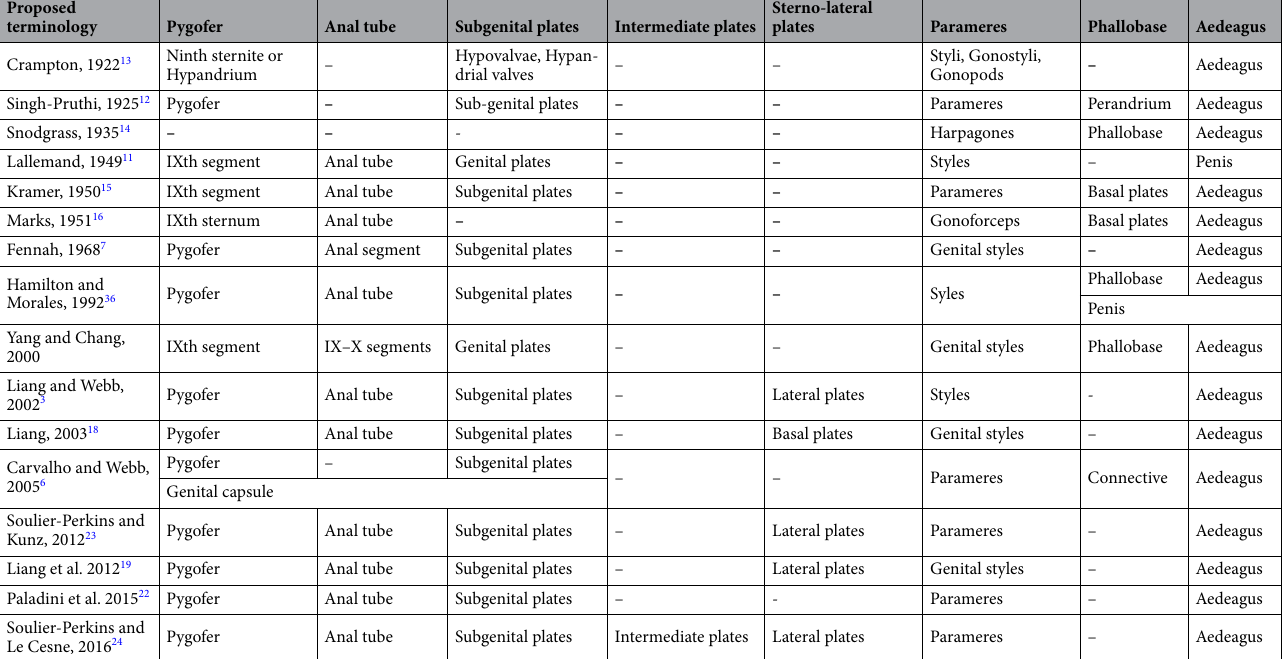
Table 1. Terminologies used by different authors since Crampton, 1922 to designate different parts of the male